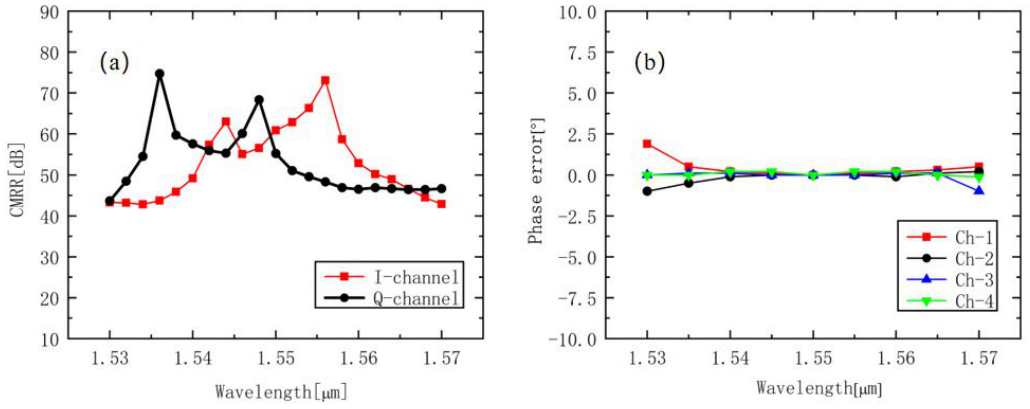
Figure 3. Simulated ( a ) common-mode rejection ratio (CMRR) and ( b ) phase error (PE) of the 90° hybrid when the refractive index of the core layer is reduced by 0.01.